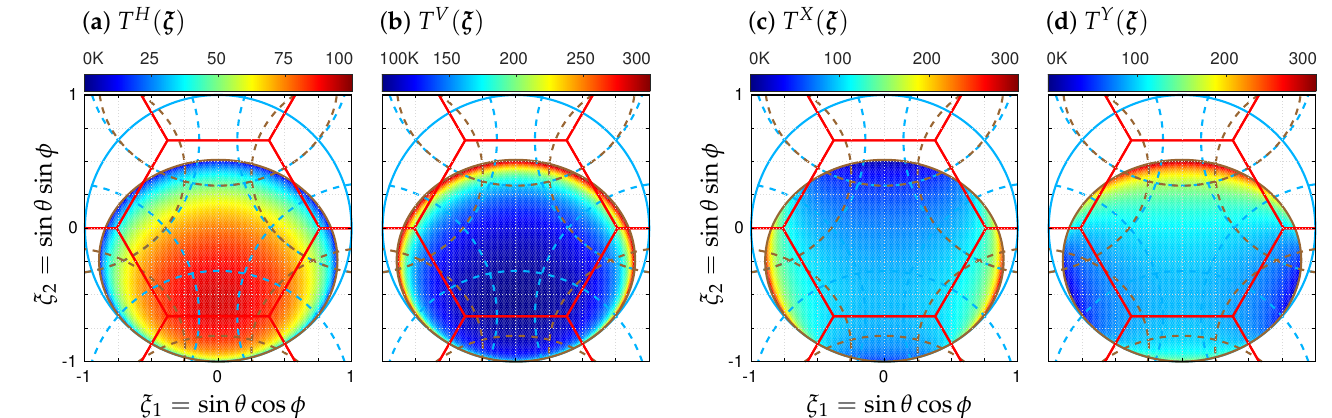
Figure 5. Brightness temperature distributions of a typical scene over the ocean: ( a ) T H ( ξ ) and ( b ) T V ( ξ ) at ground level, ( c ) T X ( ξ ) and ( d ) T Y ( ξ ) at instrument